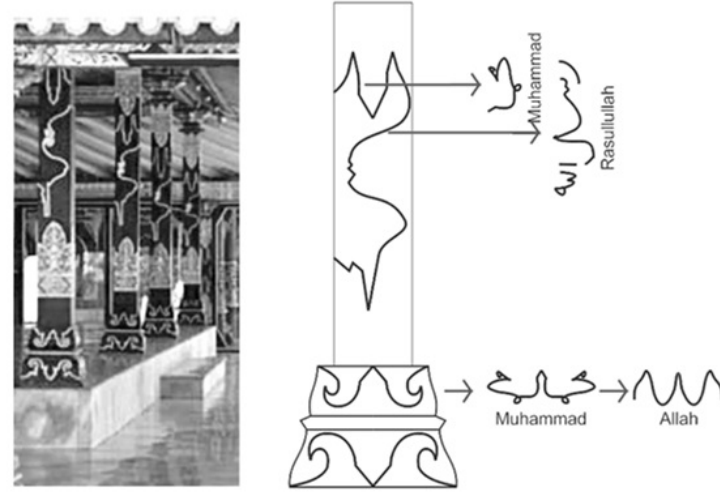
Figure 9. The spiralling pattern of Putri Mirong in columns and its’ base as a calligraphy of Allah and Muhammad (Idham,